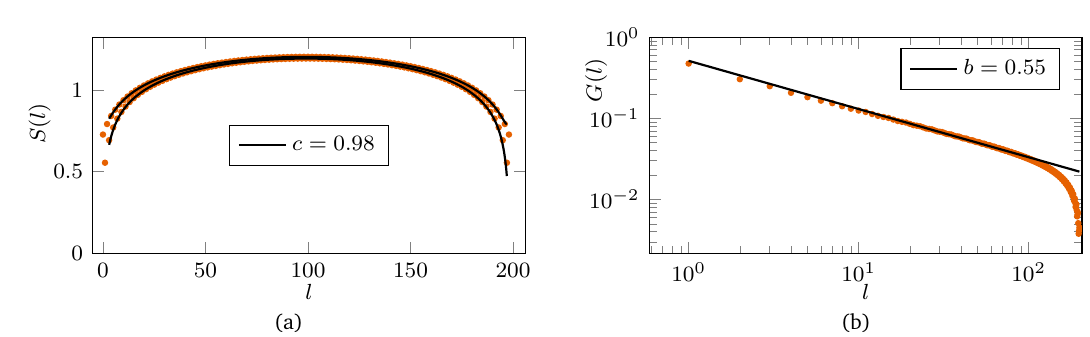
Figure 7: DMRG results (orange dots) for the (cid:90) -ANNNP model for U = − 0.25, 3 f = − 3 and L = 200. (a) Entanglement entropy together with the fitted prediction (36) (solid line). The alternation is the result of edge effects as was shown in Refer- ence [ 71 ] , see Equation (36). (b) Correlation function G ( l ) with the corresponding power scaling l − b (solid